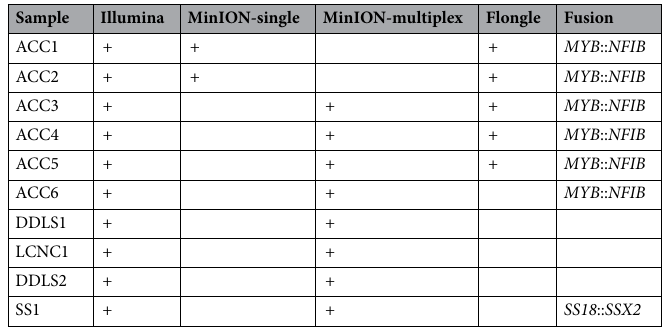
Table 1. Tumor samples. Listed are the availability of RNA-seq data (indicated by “+”) for the Illumina and various Oxford Nanopore platforms and characteristic gene fusions identified by Illumina-based